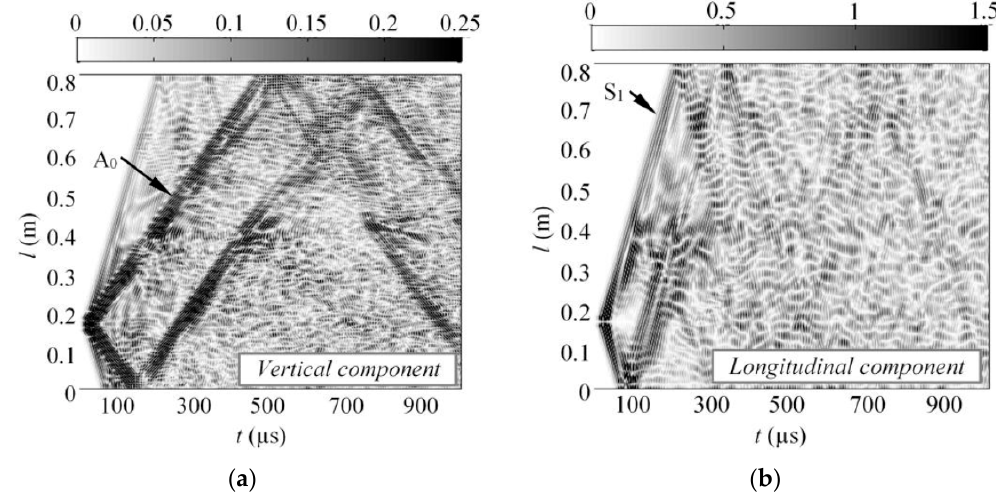
Figure 7. The simulated B-scan images of the vertical ( a ) and longitudinal ( b ) component of guided waves along the centerline of the GFRP sample.